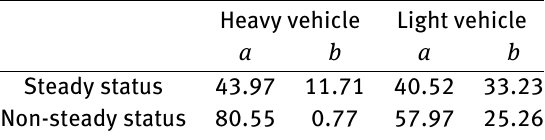
Table 3: Model parameters a and b of localized model.